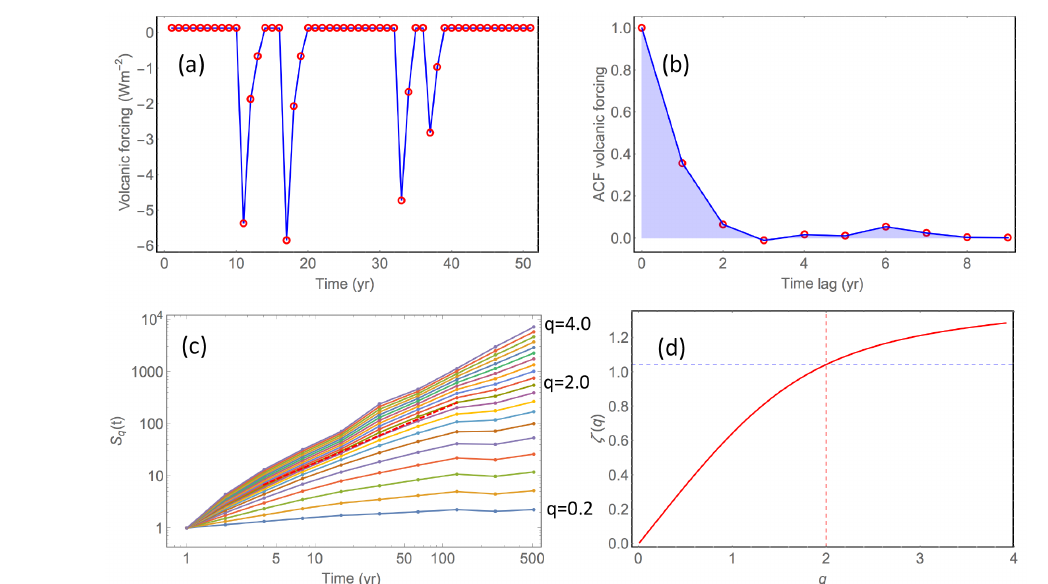
Figure 6. (a) A zoom-in on the volcanic forcing signal shown in Fig. 1a. (b) The ACF estimated for the volcanic forcing signal. (c) The structure functions (empirical moments) ˆ S q ( (cid:49)t ) for the volcanic forcing signal estimated for q = (0 . 2 , 0 . 4 ,..., 4 . 0). The red dashed line is a linear fit to the log–log plot of ˆ S 2 ( (cid:49)t ). (d) The scaling function ζ ( q ) computed from linear fits to the ˆ S q ( (cid:49)t )’s over the interval (cid:49)t ∈ (4 , 128). The observation that ζ (2) ≈ 1 suggests that the process is uncorrelated on these